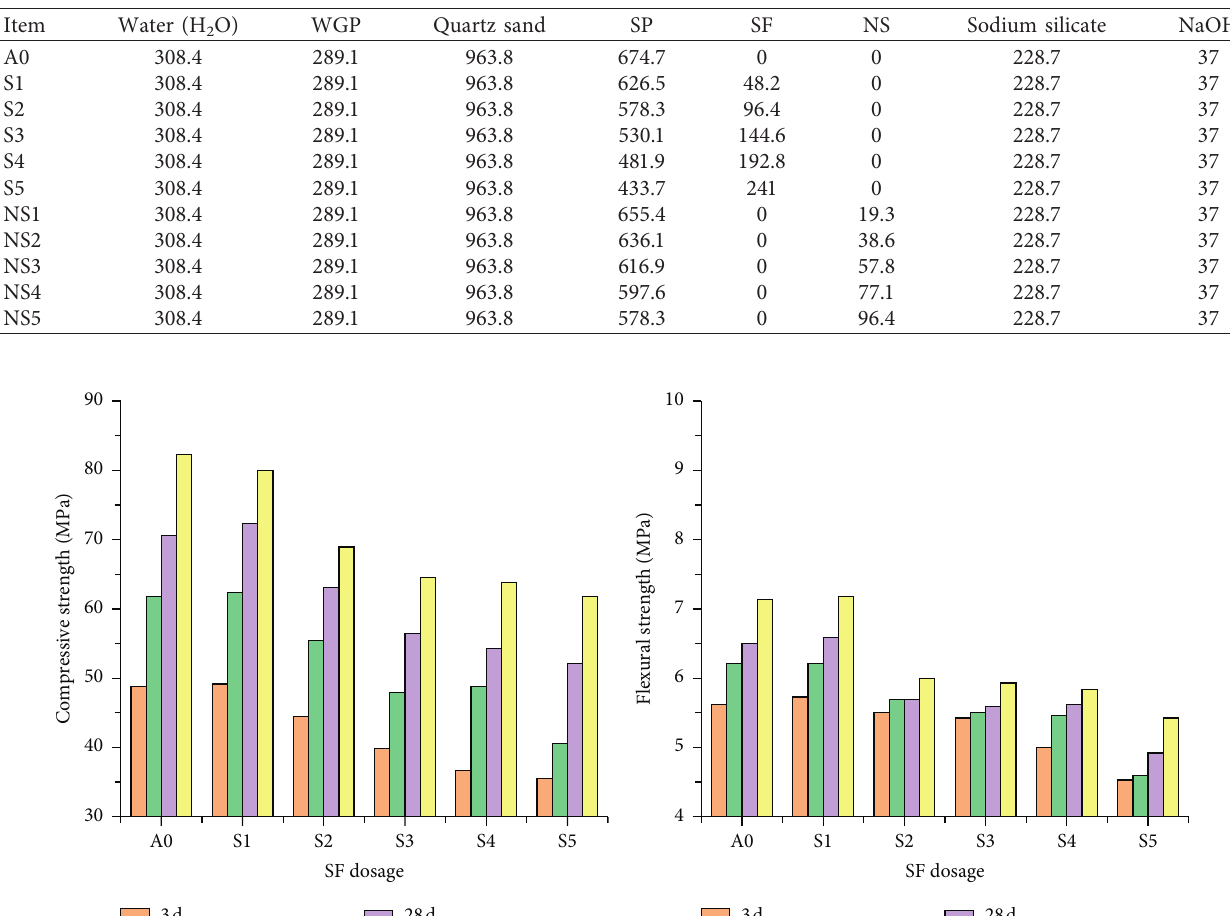
Table 2: The mix-design proportions (kg/m 3 ).